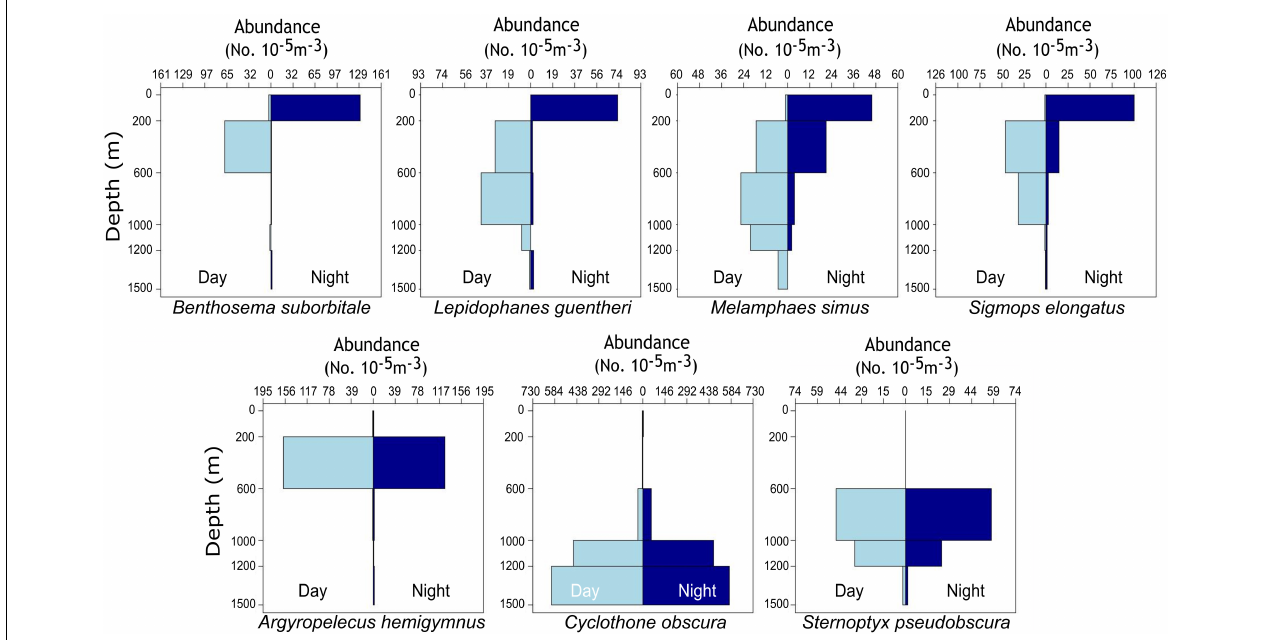
FIGURE 1 | Vertical bar plots representing the standardized abundance of migratory (top row) and non-migratory (bottom row) species collected with day and night MOCNESS tows from 2015 to 2016. Plots represent catch data for each species combined across four oceanographic cruises and not data solely from individuals used for stable isotope analysis. Abundances were standardized by the volume of water filtered during MOCNESS tows as described in Cook et al. (unpublished